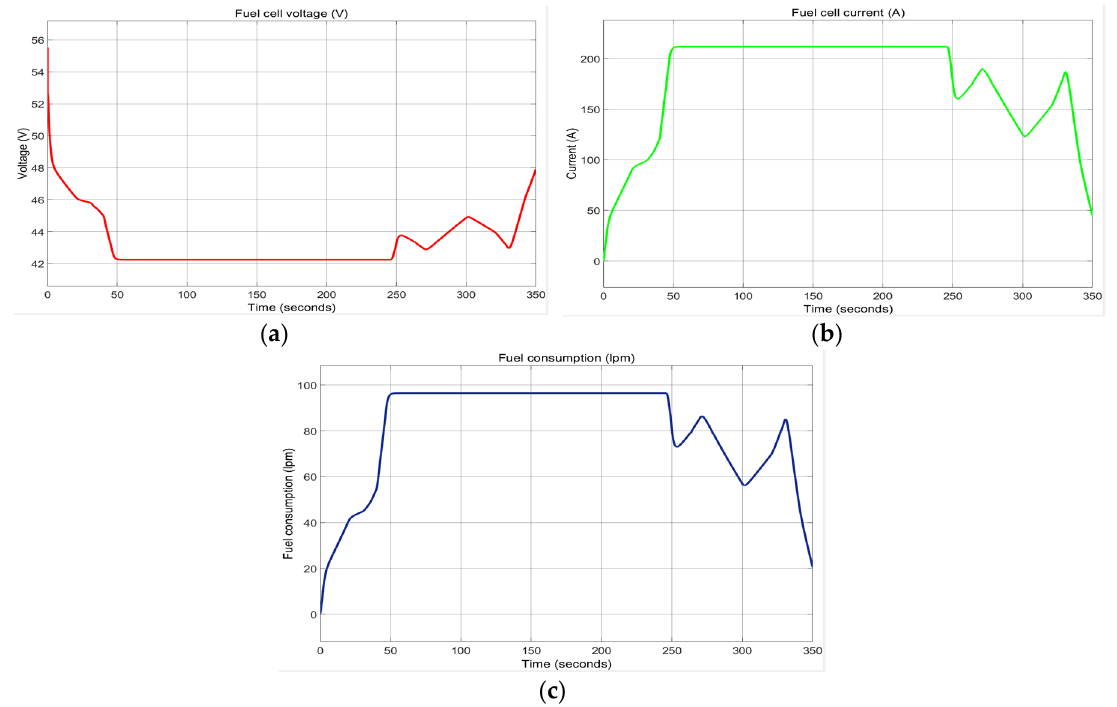
Figure A9. Fuel cell. ( a ) FC current; ( b ) FC voltage; ( c ) FC consumption.